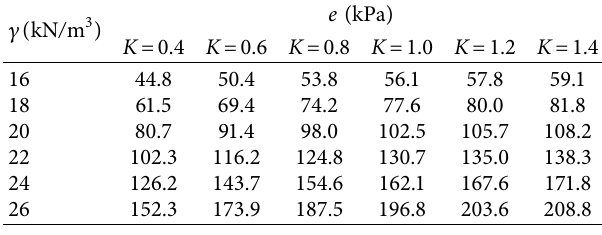
Table 2: Upper bound solution of the surrounding rock pressure e at different c and K .